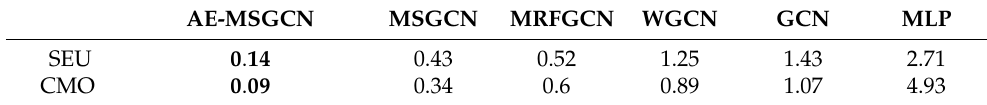
Table 7. The SD (%) of different methods for the two datasets.